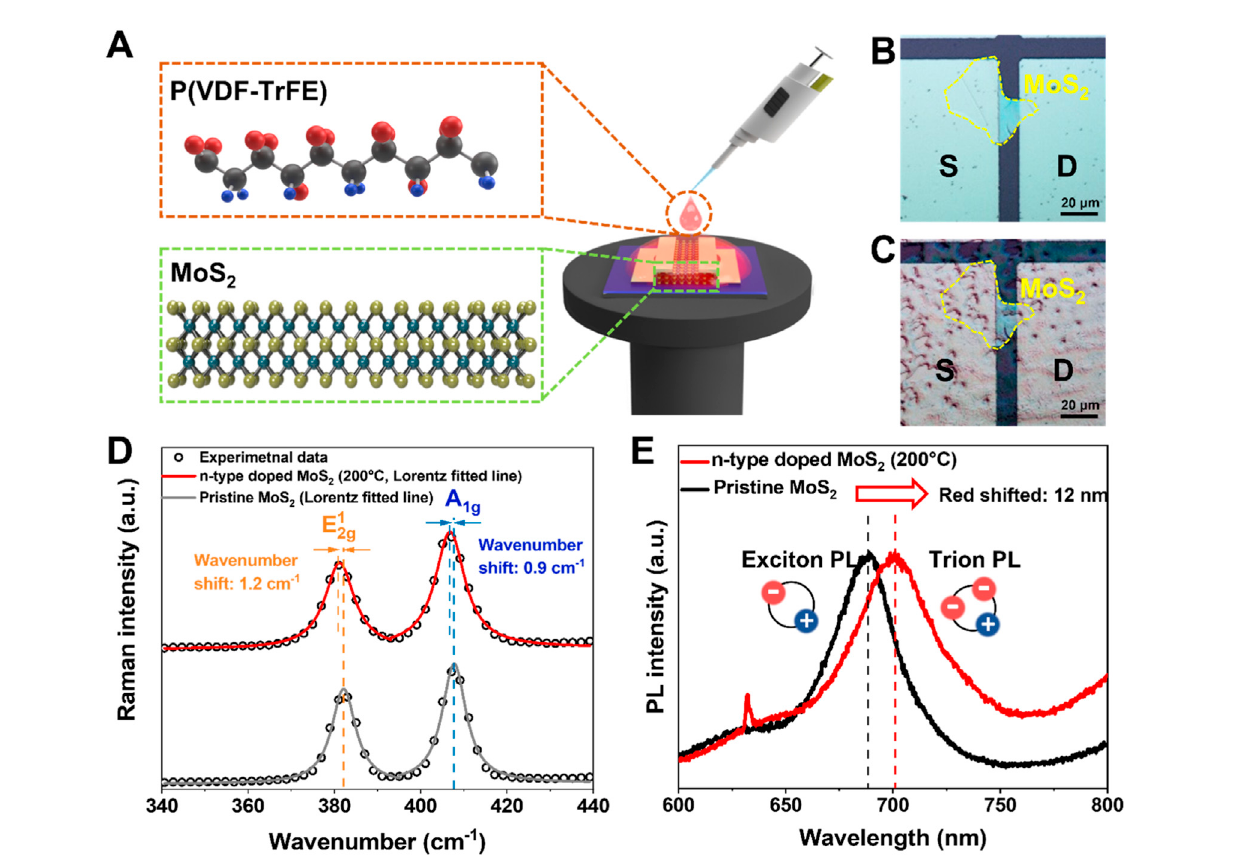
FIGURE 1 (A) Schematic diagram of dopant, MoS 2 , and doping process. Optical micrographs of the MoS 2 FETs: (B) pristine MoS 2 FET and (C) P(VDF-TrFE)-